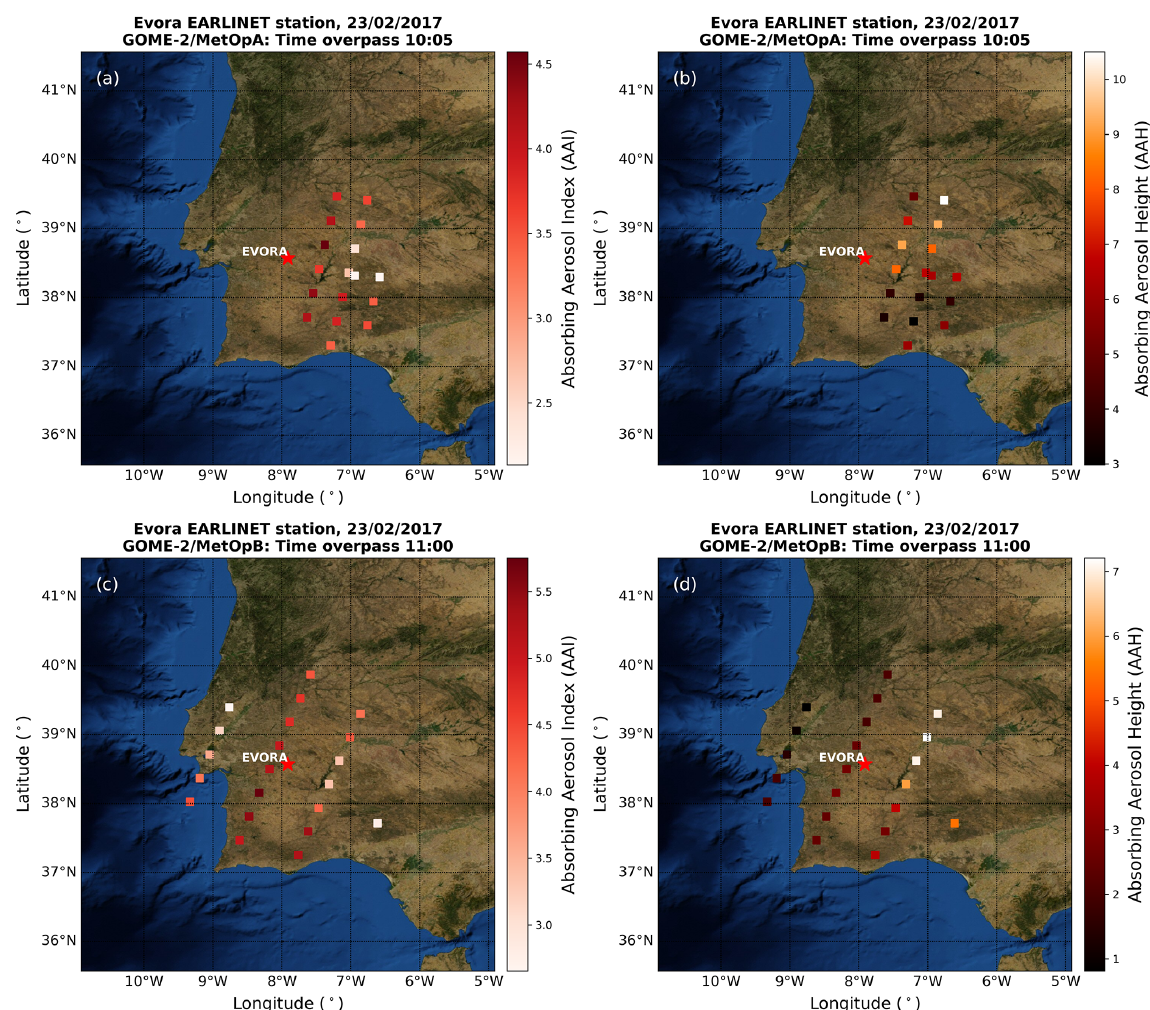
Figure 13. The Saharan dust transport on 23 February 2017 over the Iberian Peninsula. The Évora station is marked with the red star. The colour schemes illustrate the altitude of the AAH (b–d) and the AAI (a–c) as observed by GOME-2A (a–b) at 10:00UTC and GOME-2B (c– d) at